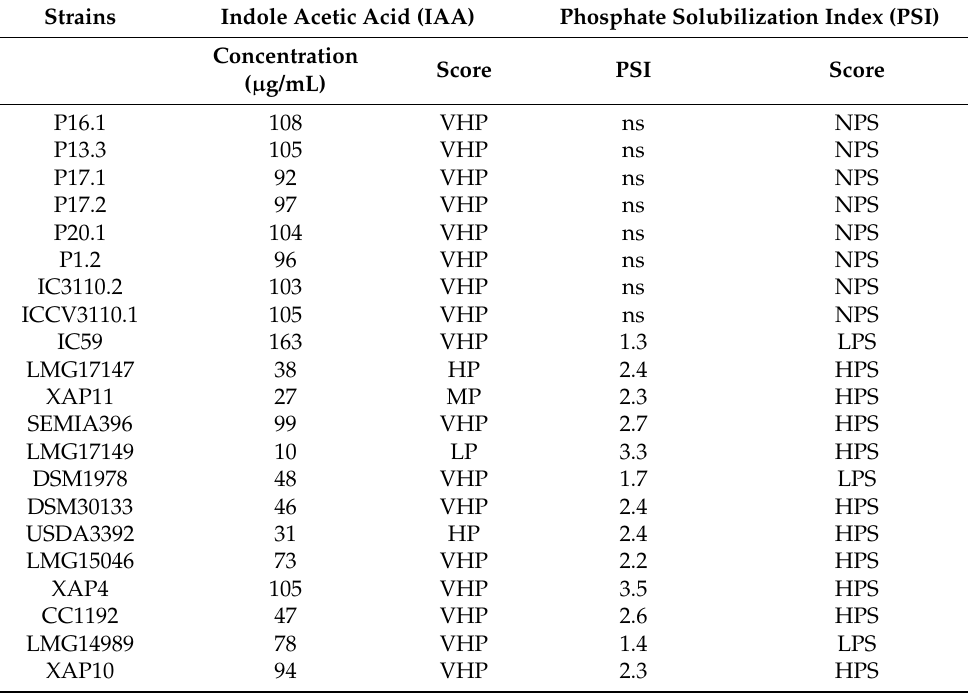
Table 4. Production and scoring of IAA production and phosphate solubilization by different Mesorhizobium isolates used in this